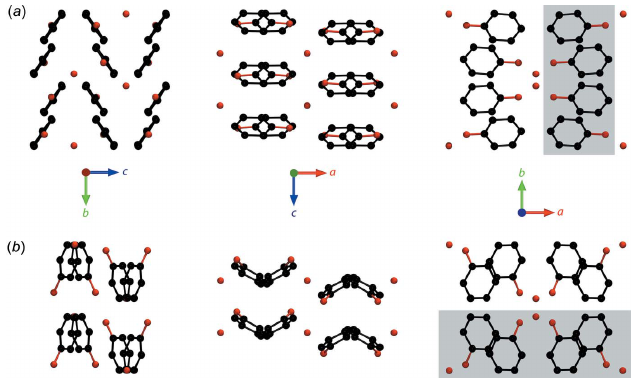
Figure 5 Illustration of the nearest-neighbour interactions in the slabs of interlocking phenol molecules ( a ) from this work and ( b ) from Meuthen & von Stackelberg (1960). Hydrogen atoms are omitted for clarity and the network of molecular centres is indicated by solid yellow